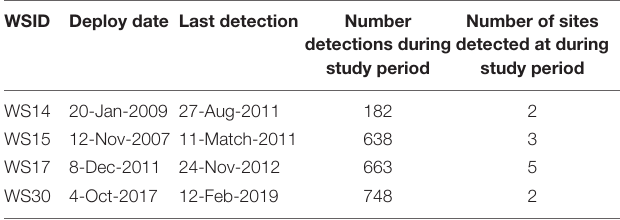
TABLE 3 | Acoustic tag data summary for double-tagged sharks. WSID Deploy date Last